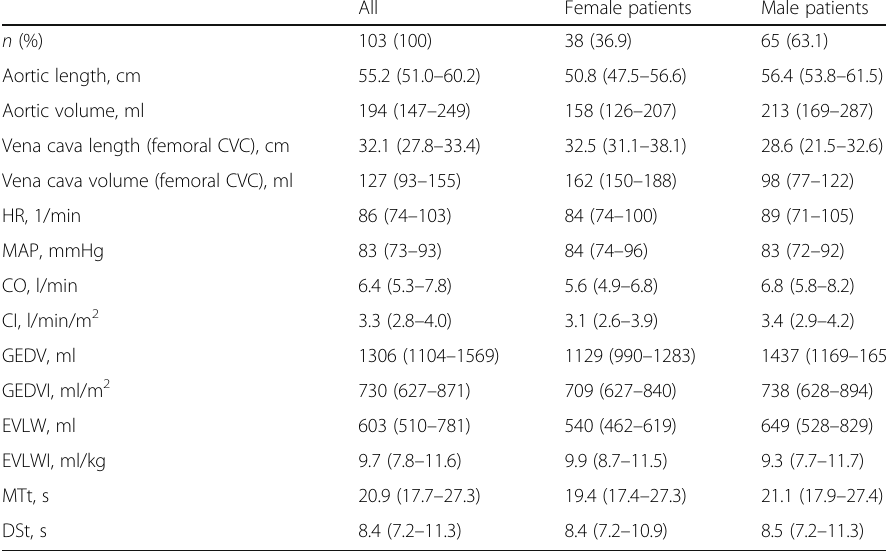
Table 3 Aortic and vena cava length and volume derived from CT scans and physiologic values from transpulmonary thermodilution measurements All Female patients Male